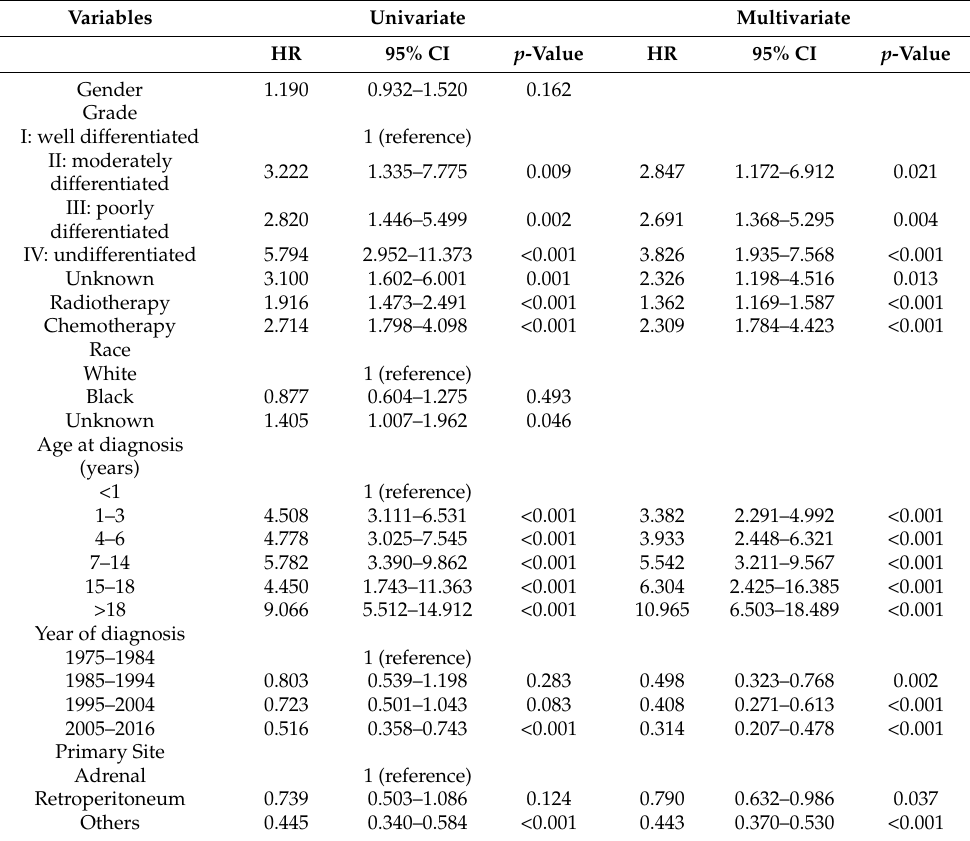
Table 4. Univariate and multivariate Cox regression analyses for predicting the mortality of patients with neuroblastoma receiving surgery. Variables Univariate